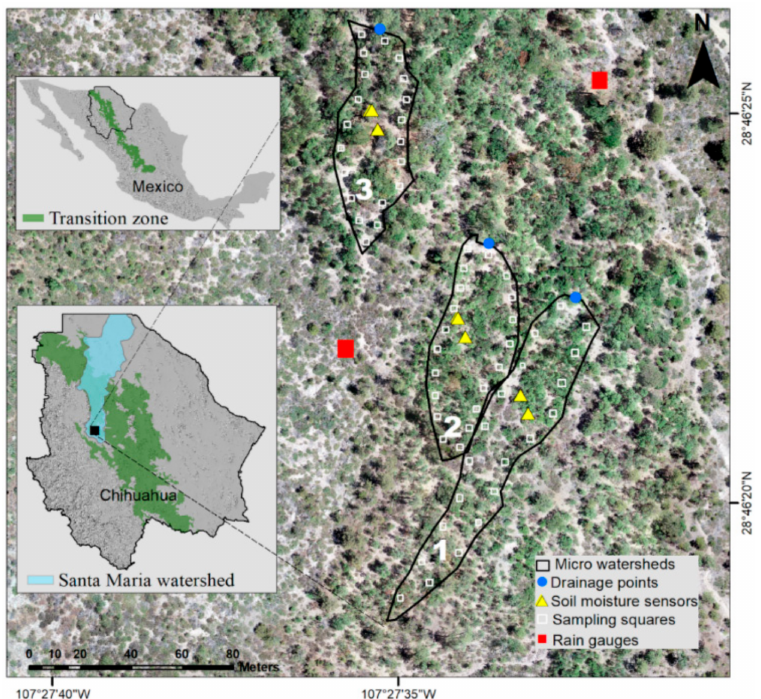
Figure 1. Location of the three micro-catchments and monitoring equipment in the study area in Chihuahua,